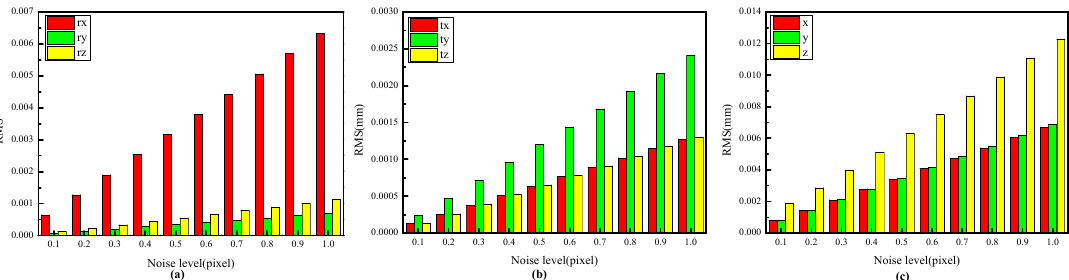
Figure 5. RMSEs of the extrinsic parameters based on the proposed method. ( a ) RMSEs of r x , r y and r z at different noise levels; ( b ) RMSEs of t x , t y and t z at different noise levels; ( c ) RMSEs of the 3D coordinates of the feature points at different noise levels.